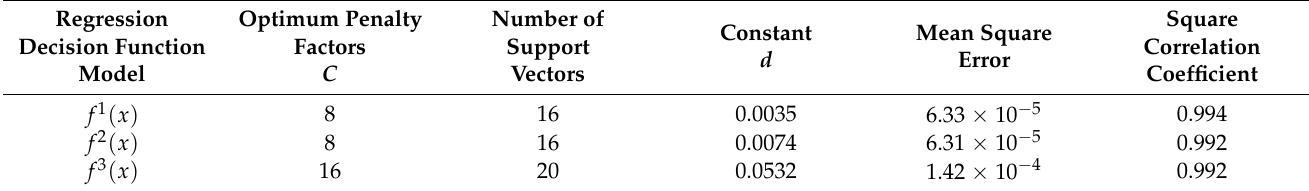
Table 1. Regression model and algorithm